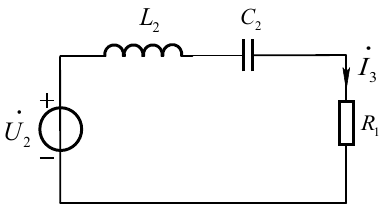
Figure 7. Thevenin equivalent circuit on the receiving side. When the power receiving device works at the resonance frequency, the resonance angular frequency is: